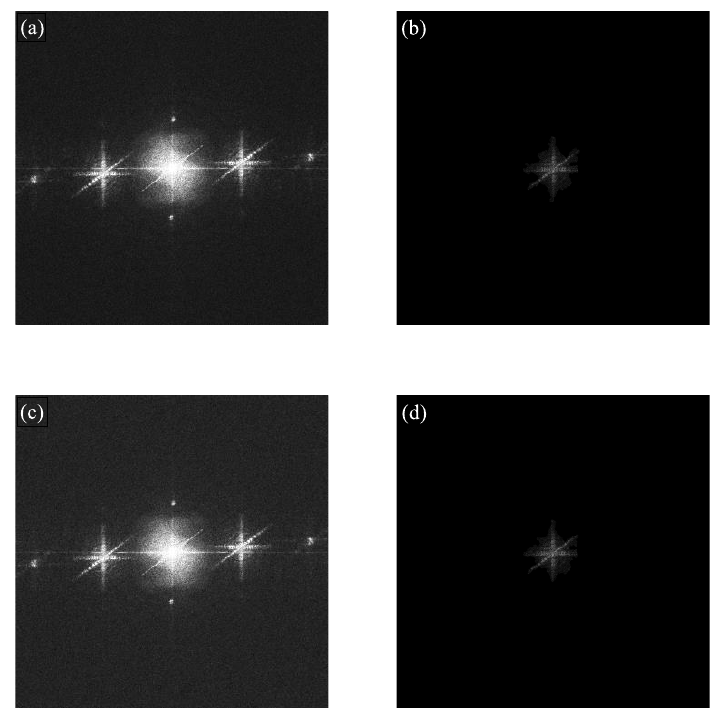
Figure 9. Hologram amplitude spectrums and filtering results with speckle noise with the method of this paper: ( a ) speckle noise with a mean of 0 and variance of 0.02; ( b ) centering after filtering; ( c ) speckle noise with a mean of 0 and variance of0.04; and ( d ) centering after filtering.